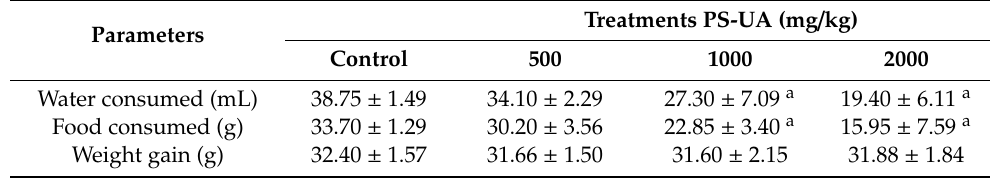
Table 2. The water and food consumption of mice from the controls and those treated with PS-UA.